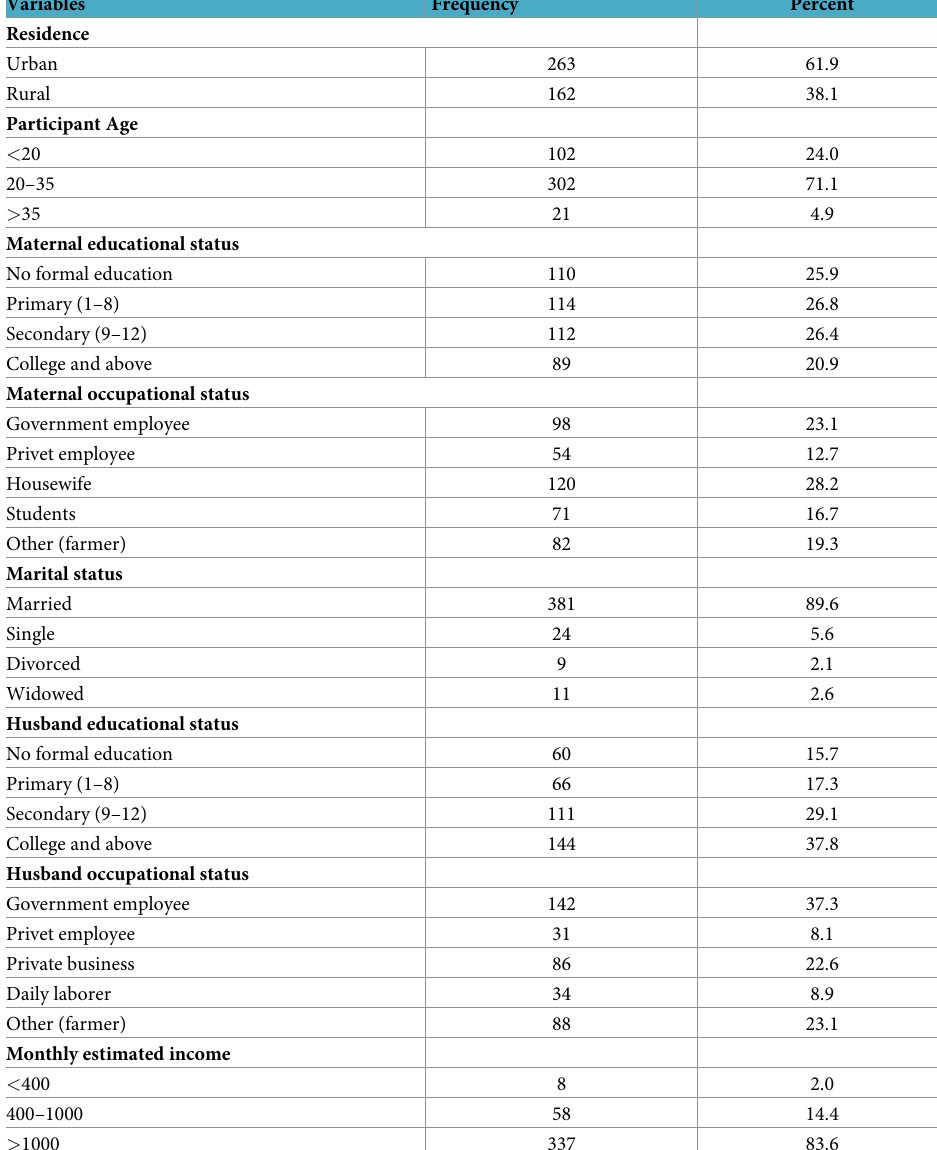
Table 1. Socio-demography characteristics of participants who visit health institutions for ANC service in Mizan- Aman town, southwest Ethiopia 2021.